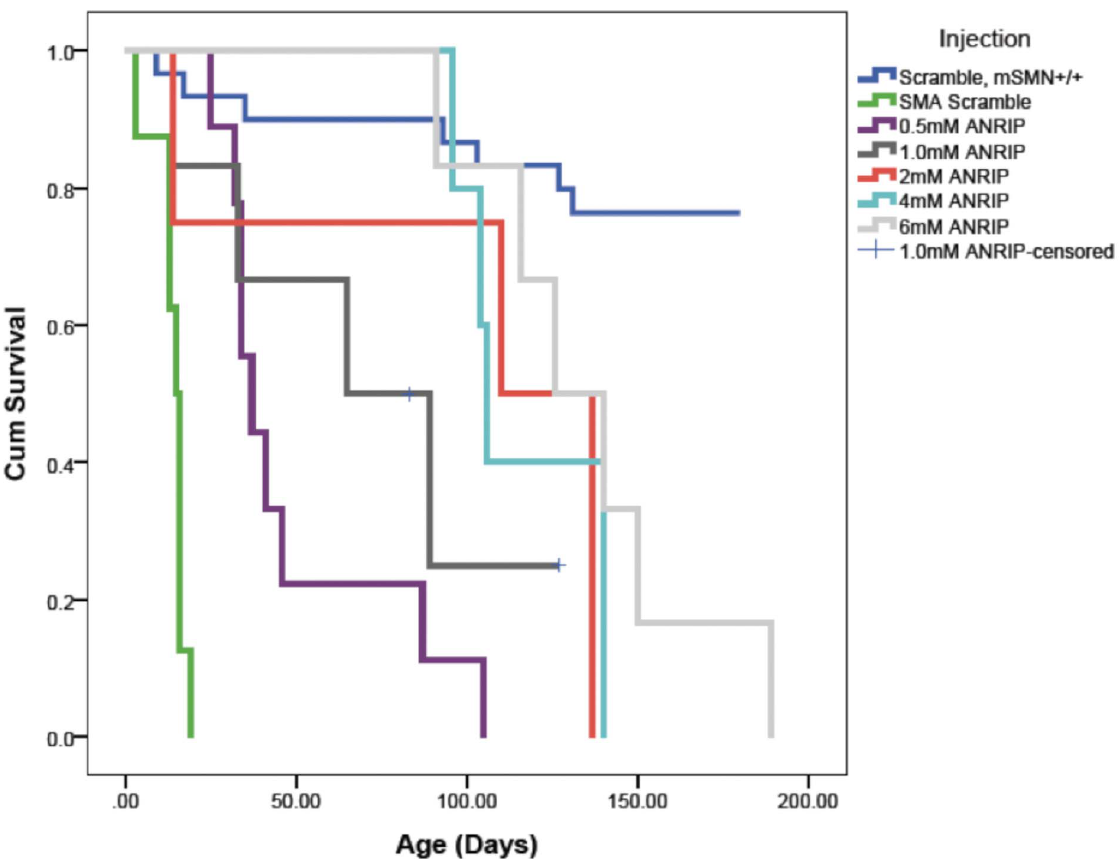
Figure 8. Survival curve of SMA mice intracerebroventricular injected with different dosage of PMO(-10-34). doi:10.1371/journal.pone.0062114.g008 PLOS ONE |